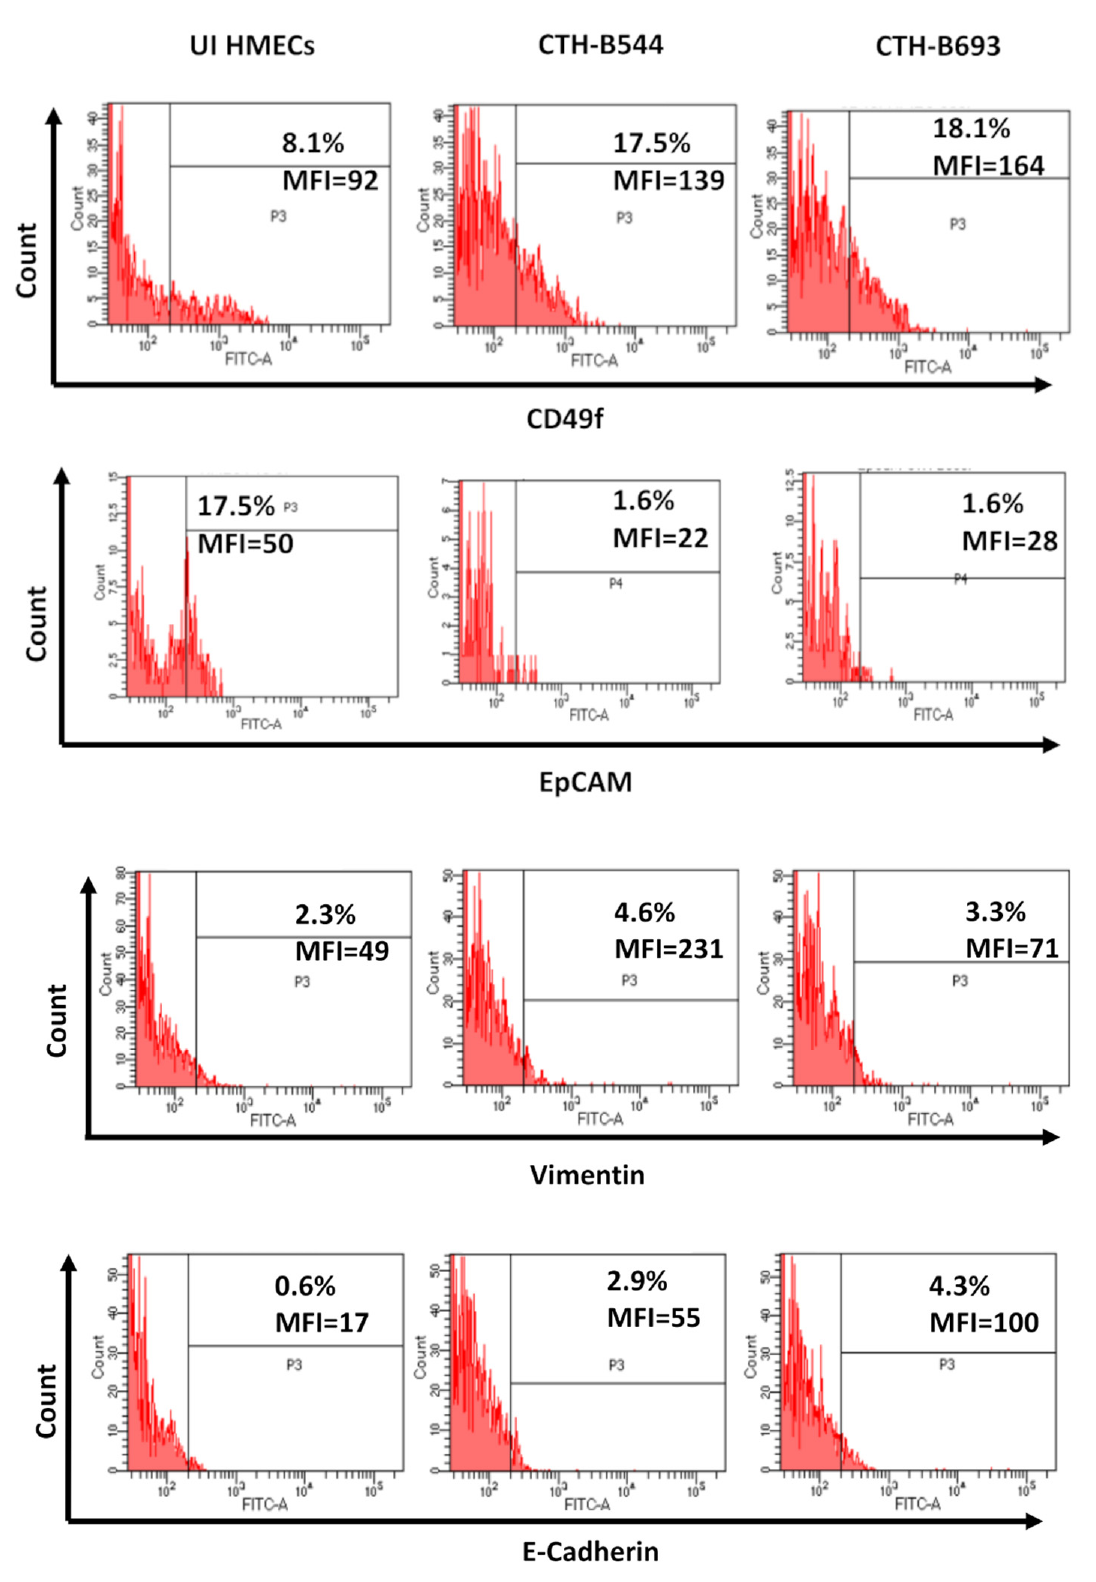
Figure 6. Phenotypic analysis of CTH cells. Detection of a panel of cell markers through FACS staining of CD49f, EpCAM, Vimentin, and E-cadherin in CTH-B544 and CTH-B693 versus UI HMECs. Results are representative of three independent experiments.